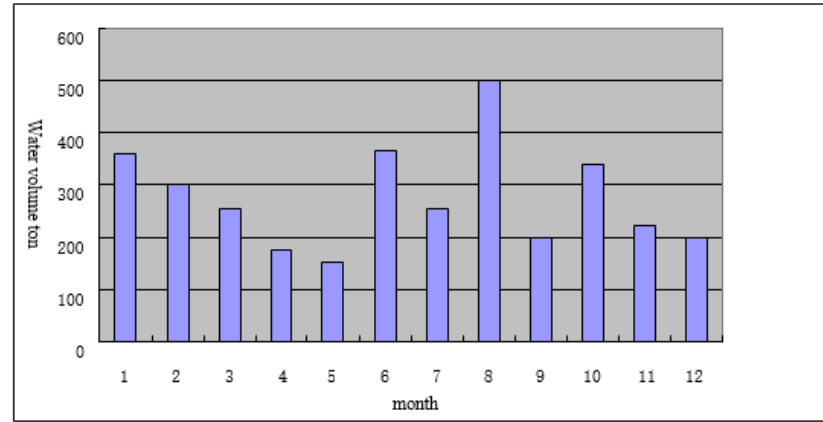
Fig. 1 The building’s annual electricity consumption chart.